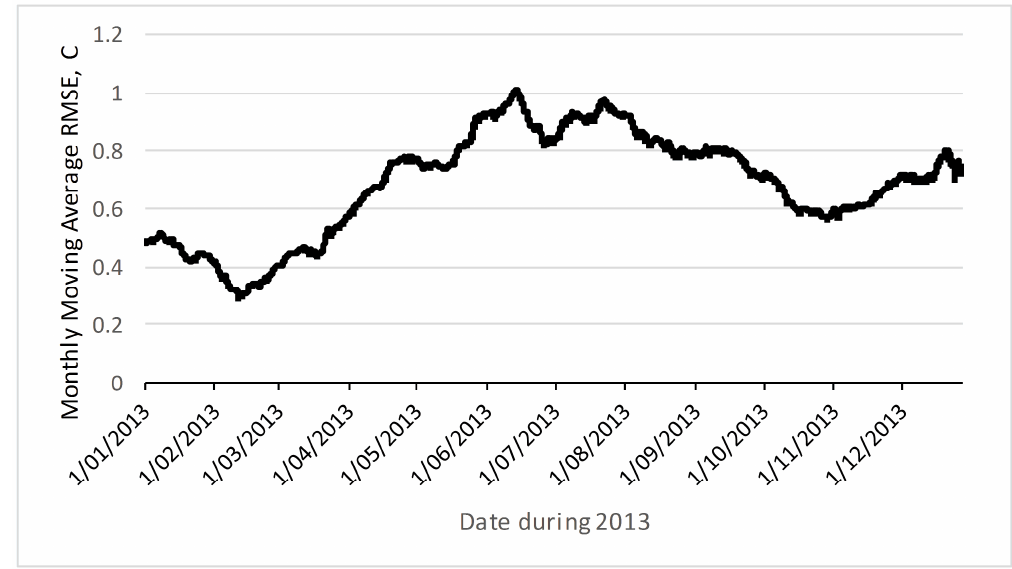
Figure 7. RMSE (moving average over 1 month) of prediction error using linear parameters from one week of training data in January.